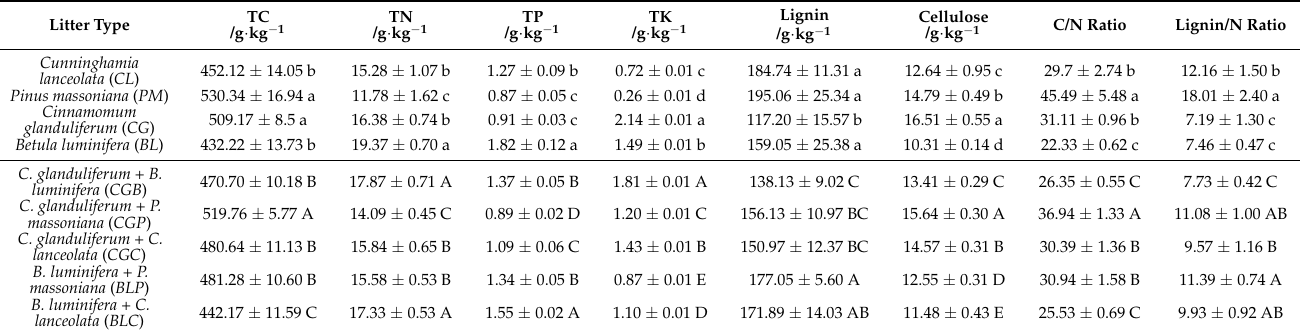
Table 1. Basic properties of nutrients in leaf litter for testing.